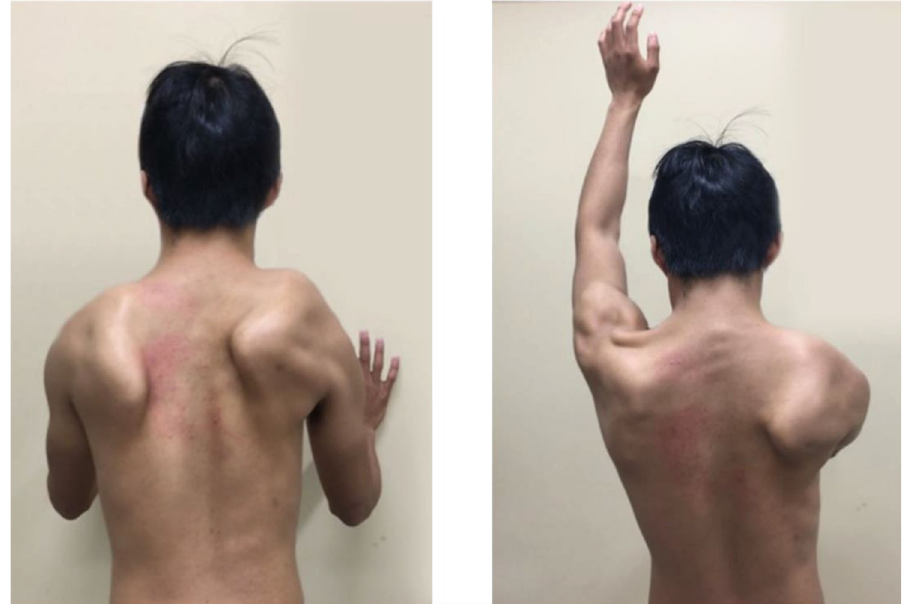
Figure 1: Bilateral scapular winging ( right > >left ) during (a) wall push test and (b) active shoulder fl exion. The patient is unable to elevate his right arm to a horizontal level.